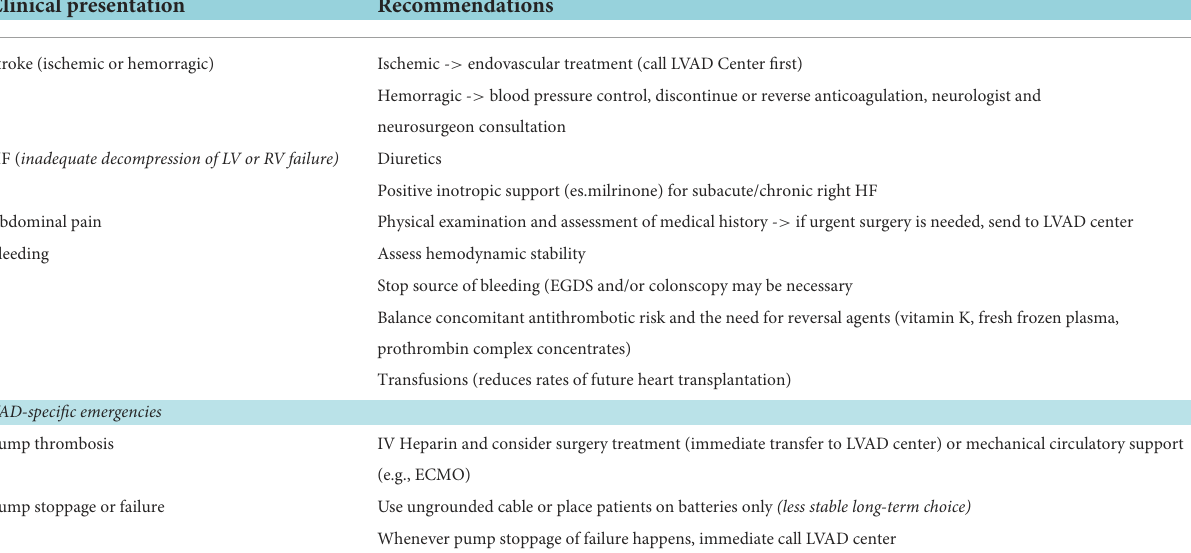
TABLE 1 Management of the main emergency conditions of patients with LVAD according to the Heart Failure Society of America (HFSA), the Society for Academic Emergency Medicine (SAEM), and the International Society for Heart and Lung Transplantation (ISHLT) consensus document (1). Clinical